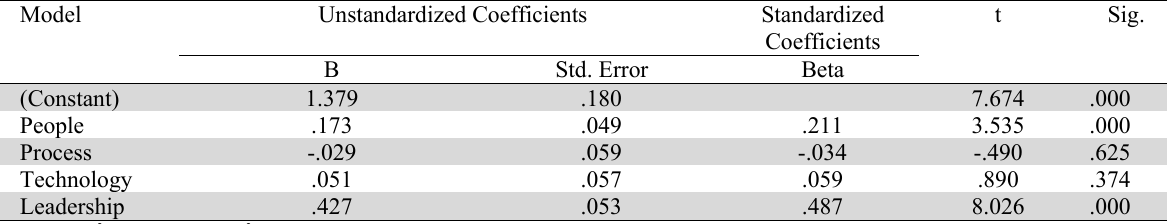
The results of regression analysis for examining the first hypothesis Model